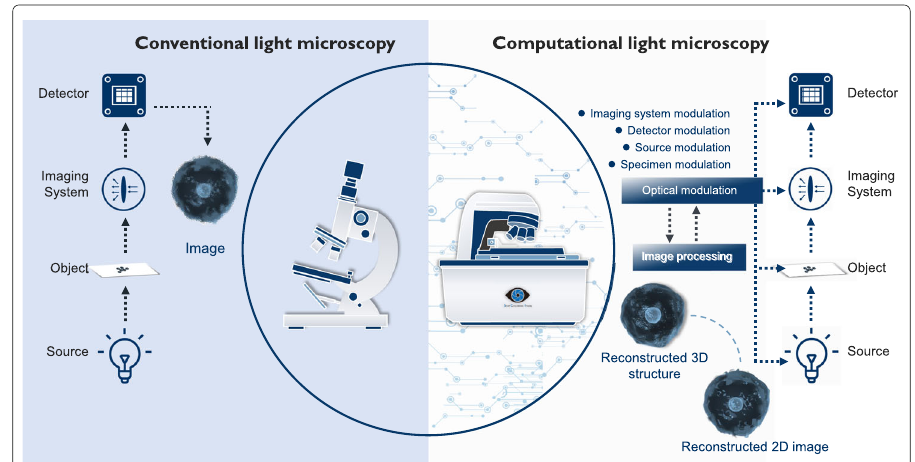
Fig. 2 Comparison of basic imaging concepts of conventional light microscopy and computational light